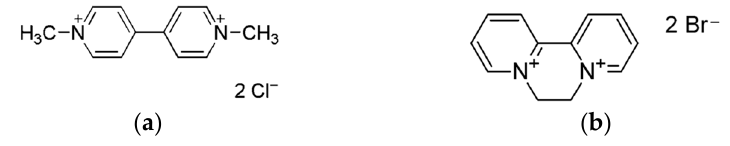
Figure 1. ( a ) Paraquat dichloride, PQ. ( b ) Diquat dibromide, DQ.